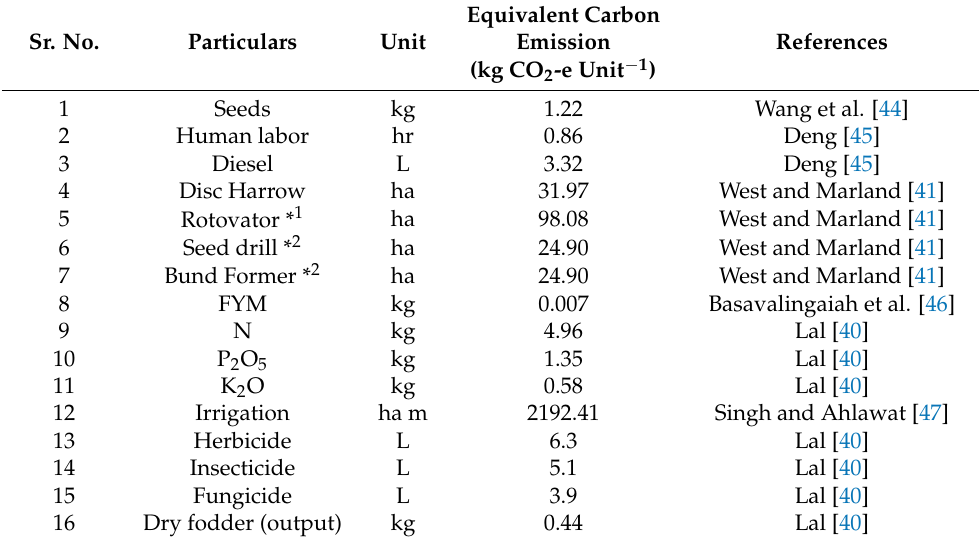
Table 3. Equivalent carbon emissions of inputs and output used for fodder maize cultivation.